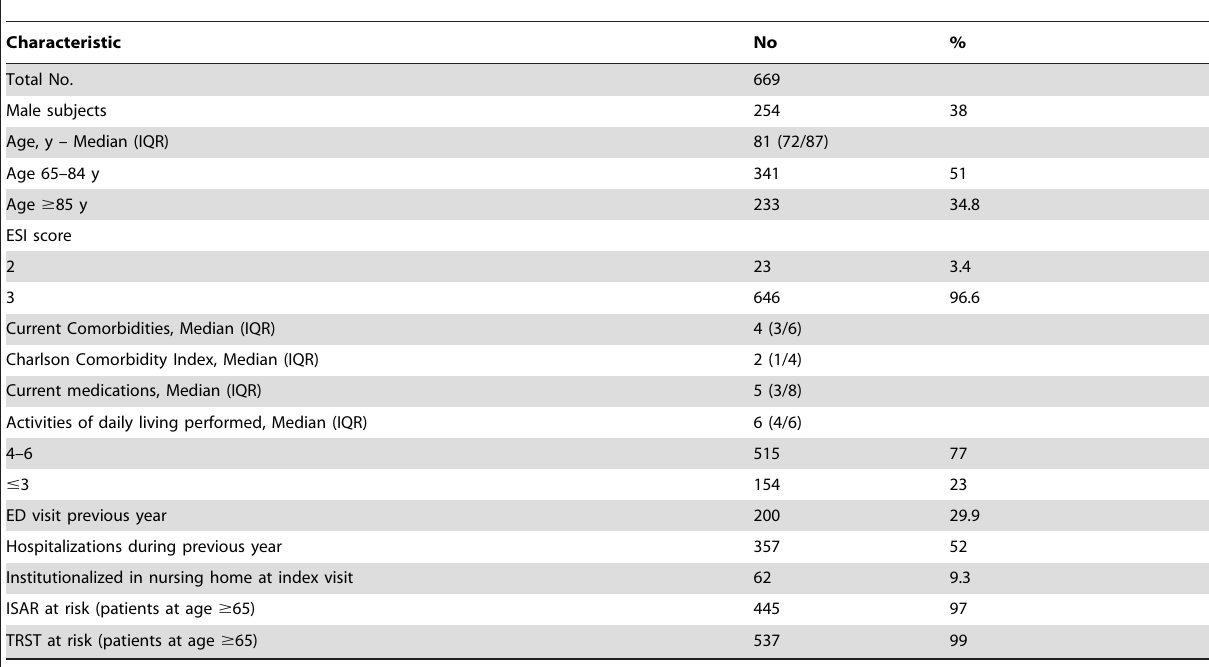
Table 1. Baseline Demographic Characteristics of the BANC Population.